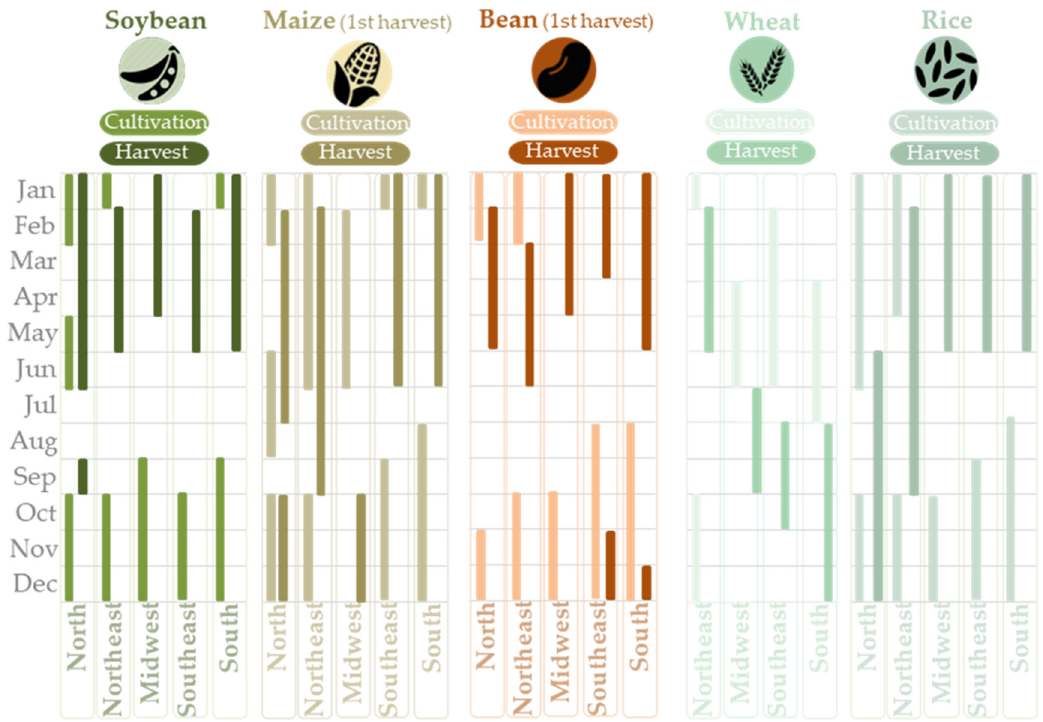
Figure 3. Brazil’s crop calendar of five main annual crops (soybean, maize, bean, wheat, and rice) by region. Source: adapted from [31,34].